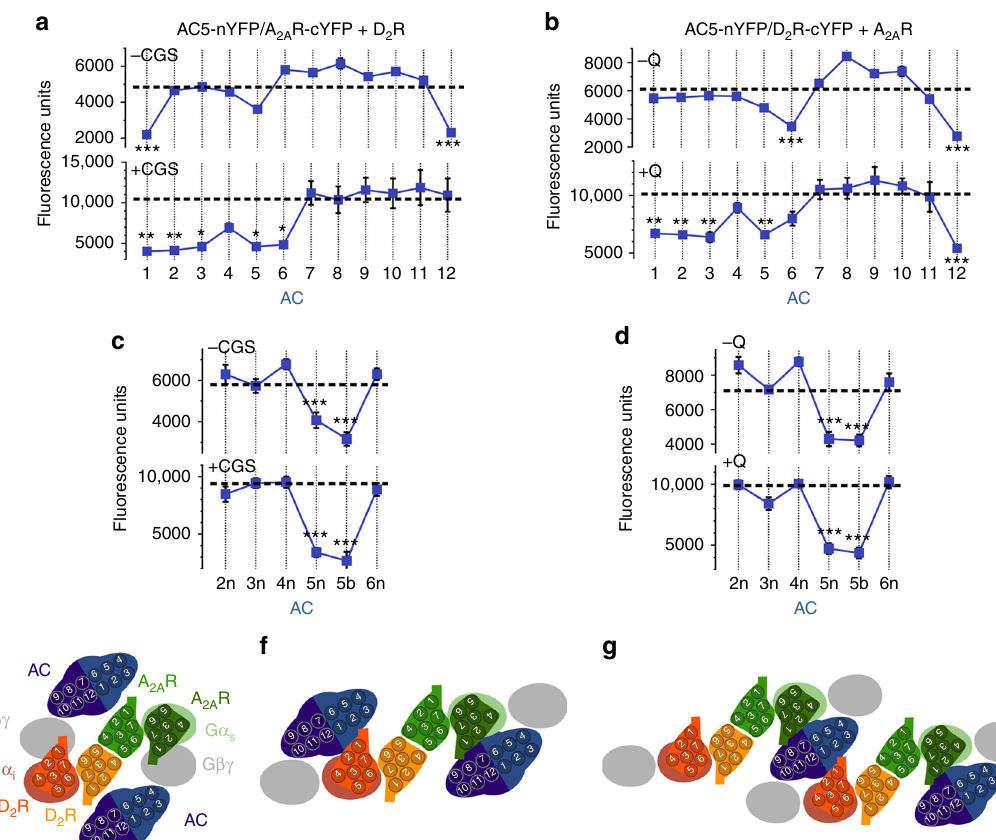
Fig. 4 Involvement of AC5 TMs in A 2A R-D 2 R heterotetramer-AC5 oligomerization. a – d BiFC experiments in HEK-293T cells transfected with AC5-nYFP (0.75 μ g), A 2A R-cYFP (0.5 μ g) and D 2 R (0.75 μ g) cDNA ( a , c ) or AC5-nYFP (0.75 μ g), D 2 R-cYFP (0.75 μ g) and A 2A R (0.4 μ g) cDNA ( b , d ); cells were treated for 4 h with medium (dotted lines) or 4 μ M of indicated TM peptides predicted from Uniprot algorithm (numbered 1 – 12) ( a , b ) or control peptides (numbered 2n − 6n and 5b; see text) ( c , d ), before addition of medium, CGS21680 (CGS; 100 nM) or quinpirole (Q; 1 μ M); fl uorescence was detected at 530 nm and values (in means ± SEM) are expressed as arbitrary fl uorescent units ( n = 8, with triplicates); *, ** and *** represent signi fi cantly lower values as compared to control values ( p < 0.05, p < 0.01, and p < 0.001, respectively; one-way ANOVA followed by Dunnett ’ s multiple comparison tests). e – g Schematic slice-representations of A 2A R – D 2 R heterotetramer-AC5 models: heterotetramer coupled with two AC5 molecules in the absence ( e ) and in the presence ( f ) of agonists; extension of the agonist-bound complex with a second A 2A R – D 2 R heterotetramer, with simultaneous binding of both G α s and G α i to the central C1 and C2 domains of AC5 ( g ). Schematic slice-representation viewed from the extracellular side of the A 2A R – D 2 R heterotetramer in complex with Gs, Gi, and AC5 in the absence and presence of agonists are shown in Supplementary Fig.